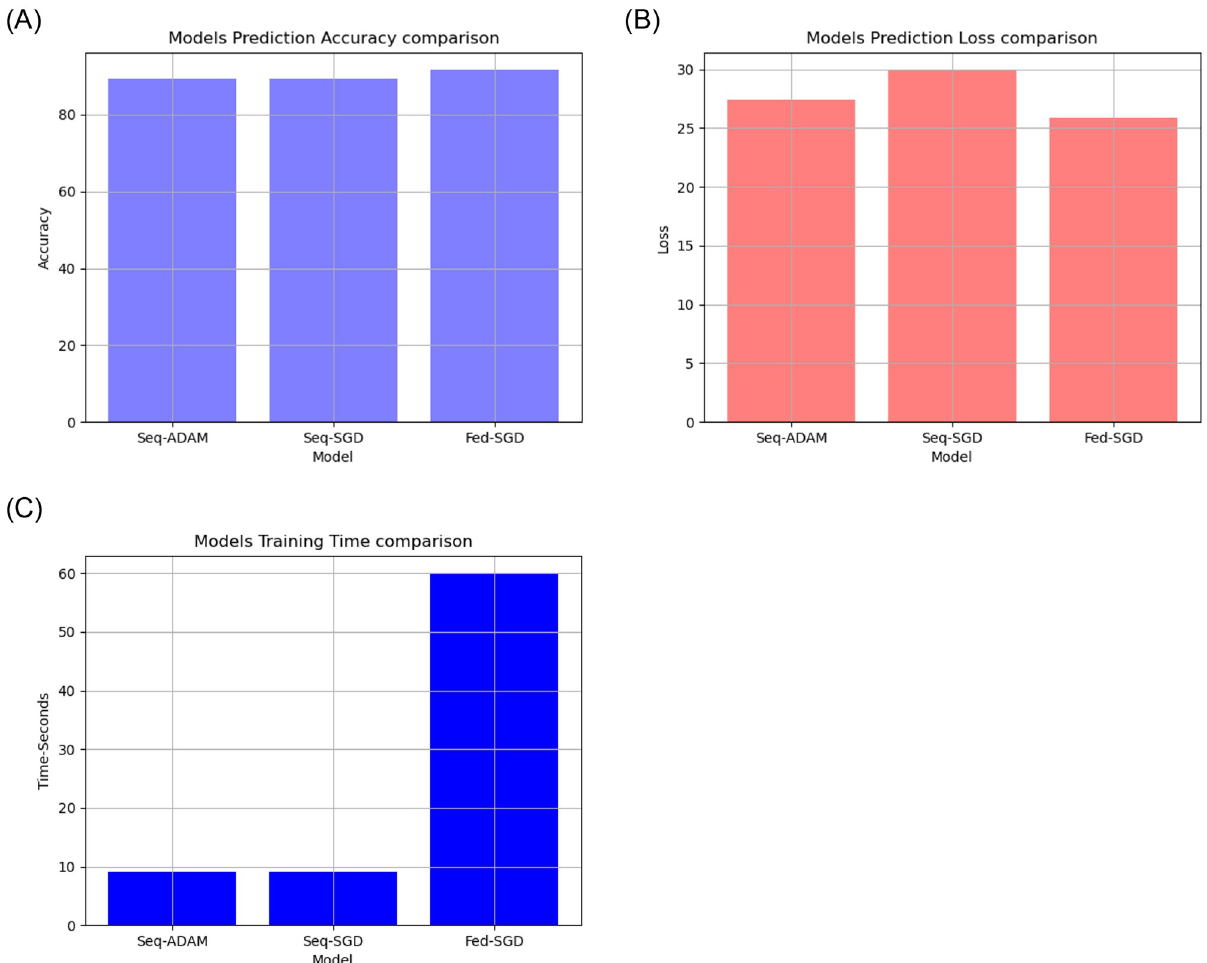
Fig 6. Model accuracy, loss and time comparison on descriptive patient’s dataset.